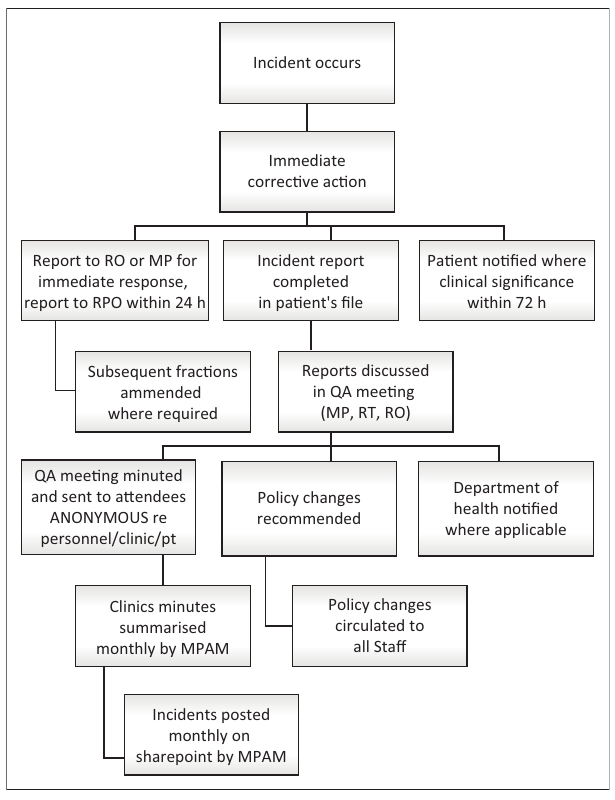
FIGURE 1: Independent clinical oncology network’s incident reporting